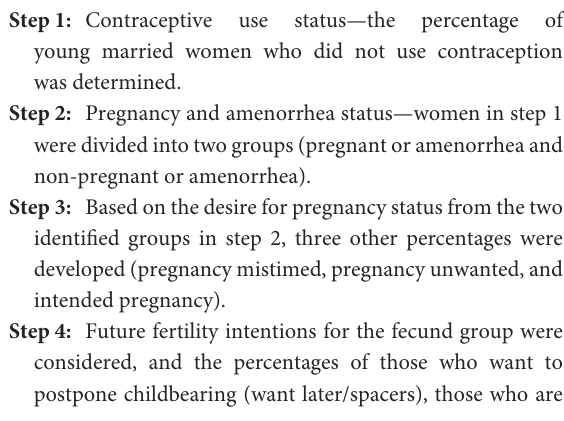
Step 1: Contraceptive use status—the percentage of young married women who did not use contraception was